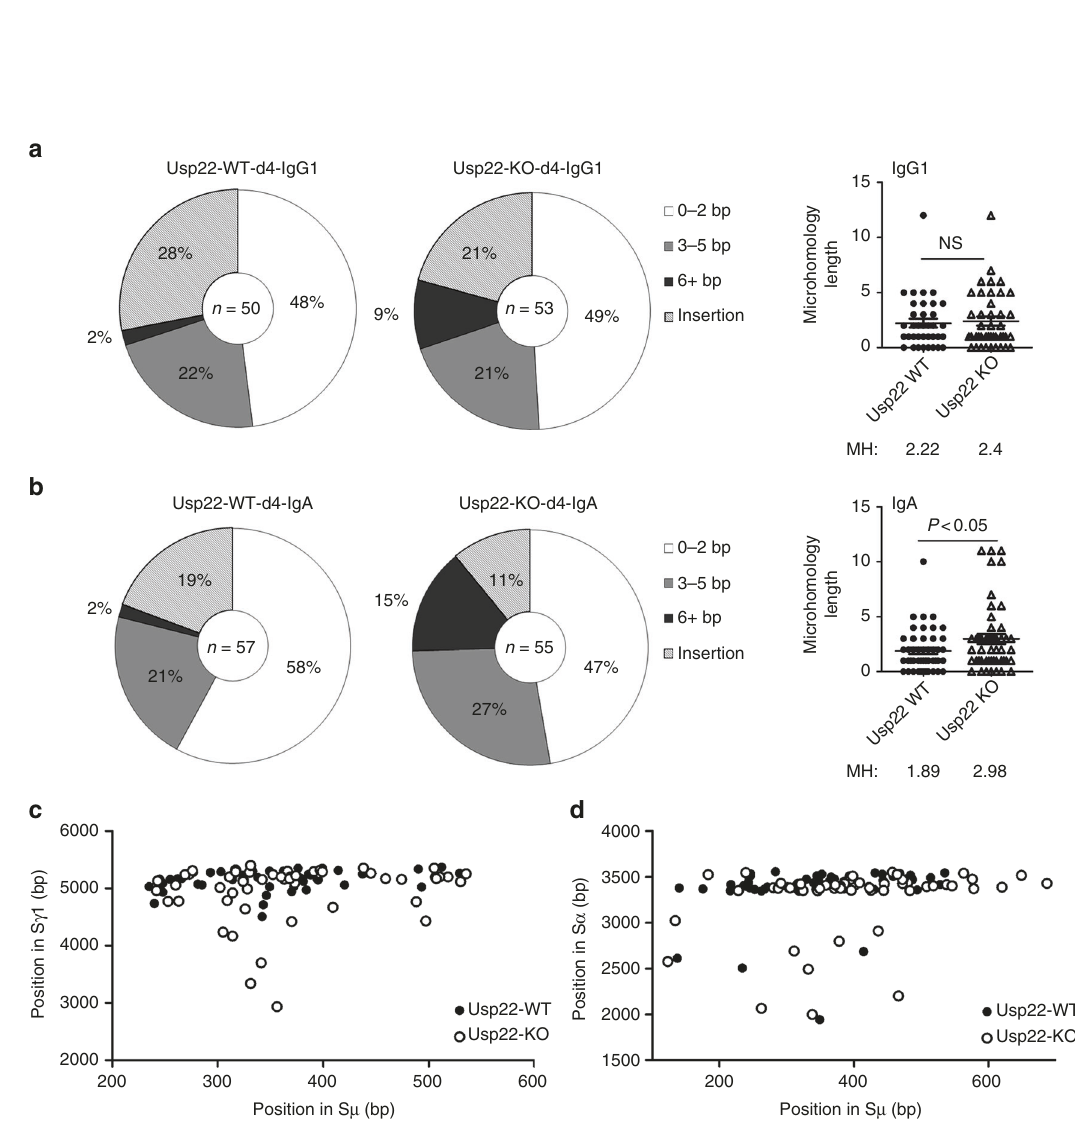
Fig. 4 Microhomology analysis of switch junctions of IgG1- or IgA-switched spleen B cells. Spleen B cells isolated from CD19-cre-Usp22 KO or WT littermates were induced for IgG1 ( a and c ) or IgA ( b and d ) CSR ex vivo for 4 days. IgG1 and IgA switch junctions were cloned from these cells, and subjected to sequencing. Approximately 50 – 60 unique switch junction sequences were analyzed per group. a S μ /S γ 1 or b S μ /S α junctions were categorized based on their microhomology usage: near-blunt joins (0 – 2 bp), joins with microhomology (3 – 5 bp or 6 + bp), or insertions. The microhomology length (MH) used by each unique switch junction sequence are summarized (right panel). c Distribution of breakpoints across μ or γ